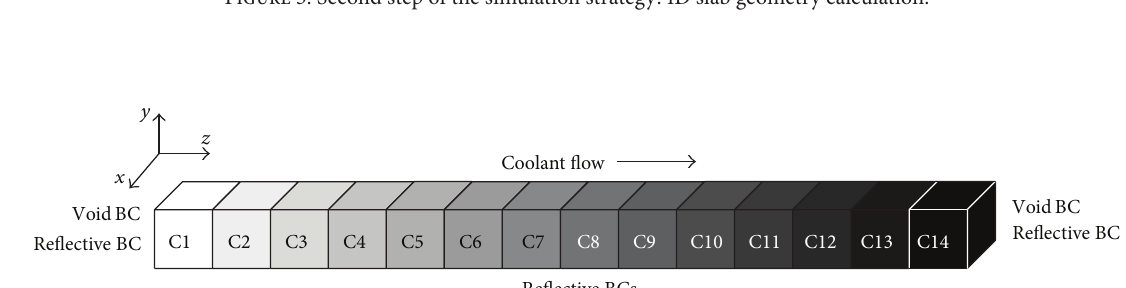
Figure 5: Second step of the simulation strategy: 1D slab geometry calculation.